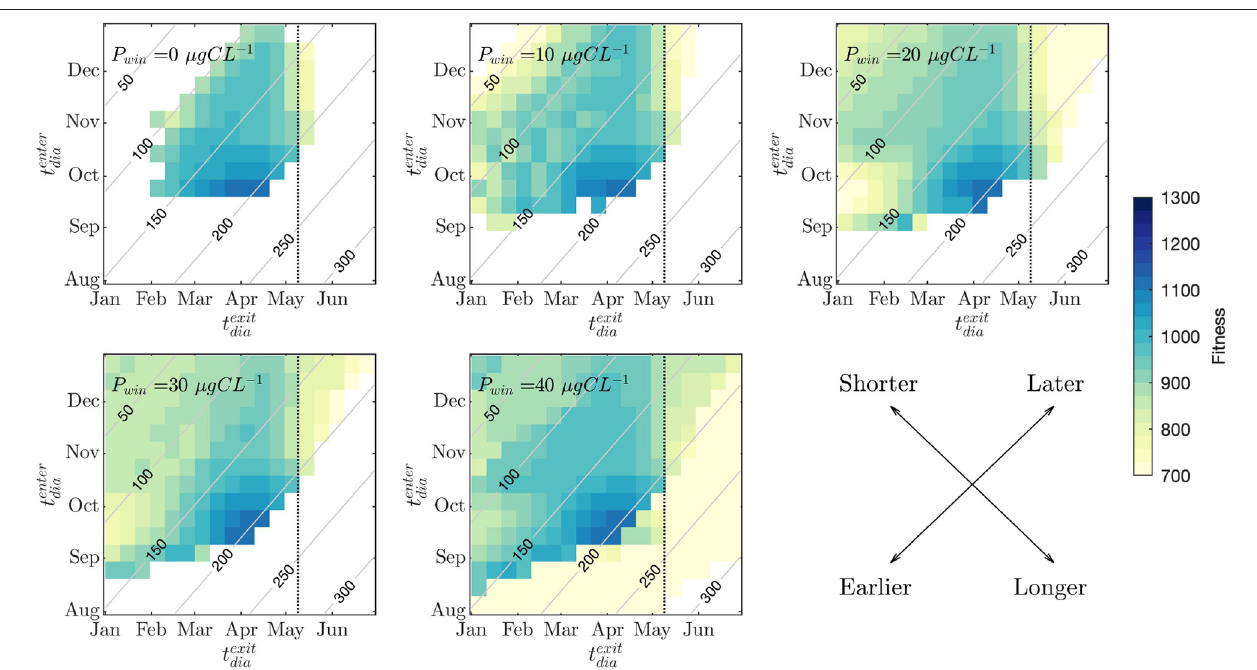
FIGURE 7 | Diapause timing experiments. Individual plots show model experiments for each value of minimum prey availability ( P win ). Fitness outcomes of each combination of diapause entry date ( t enter dia ) and diapause exit date ( t exit dia ) timing are shown in color. The date of the spring bloom maximum (10-May) is plotted using a dotted line. Gray contours show diapause duration in days. The bottom right plot shows a schematic for interpreting the results. Shorter and longer refer to diapause durations, and earlier and later to ( t enter dia ) and ( t exit dia )